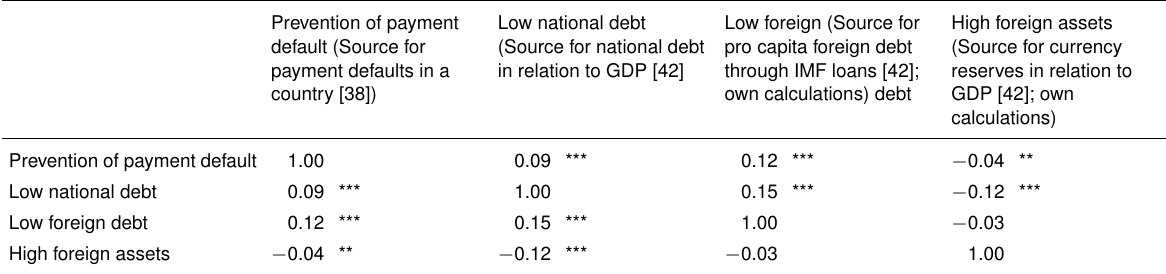
Table 1. Target dimensions of fiscal sustainability and correlation. results Prevention of payment default (Source